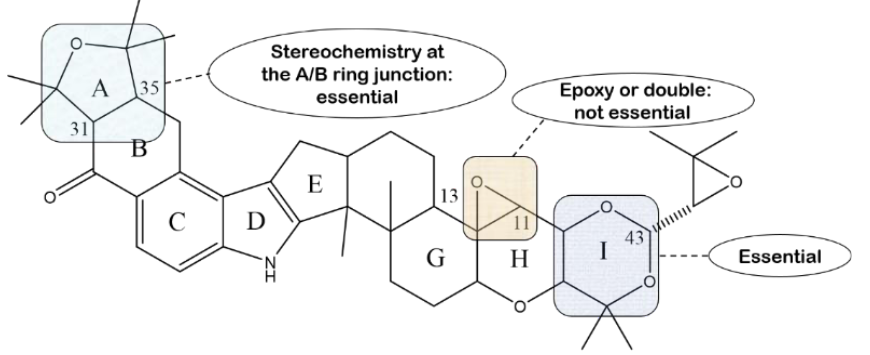
Figure 18. Structure – tremorgenic activity relationship of lolitrem indole diterpenes.